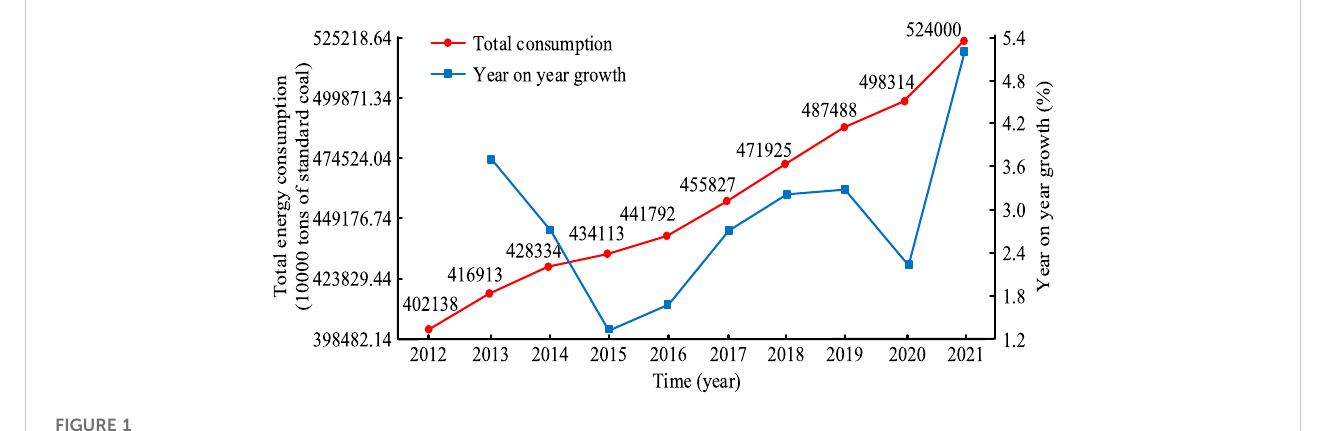
FIGURE 1 Total energy consumption and growth in China from 2012 to